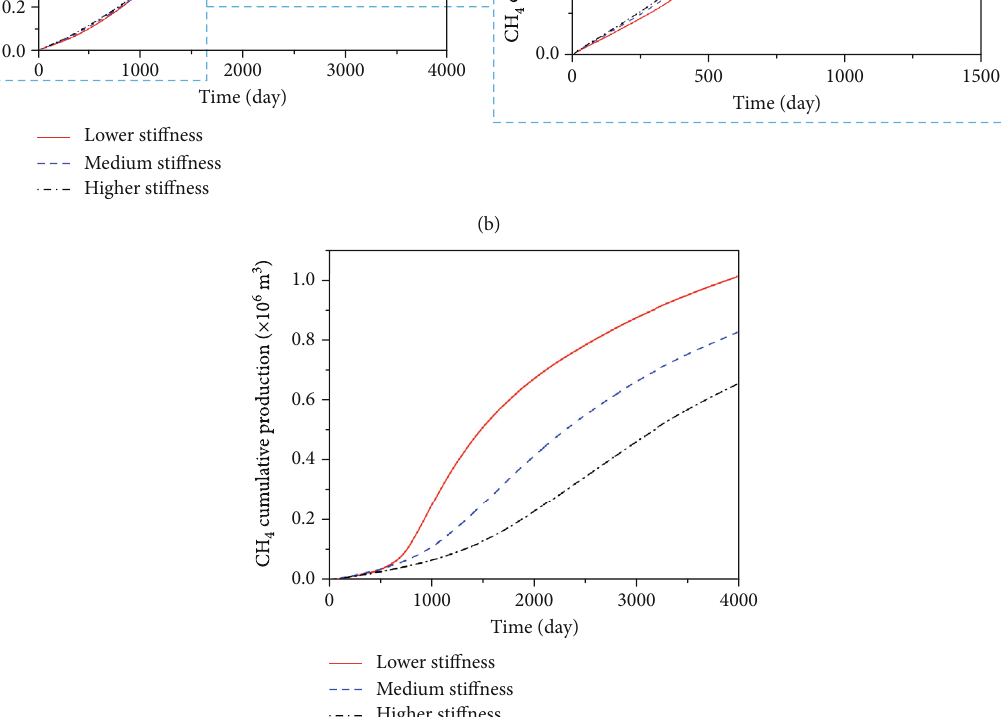
cumulative production under di ff erent reservoir geomechanical properties. (a) Primary production. (b) CO